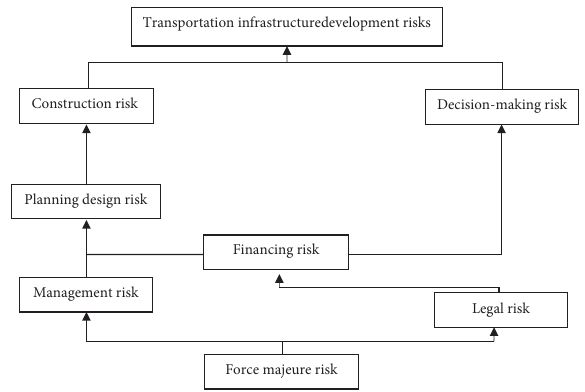
Figure 2: Results priority directed topological hierarchy graph.